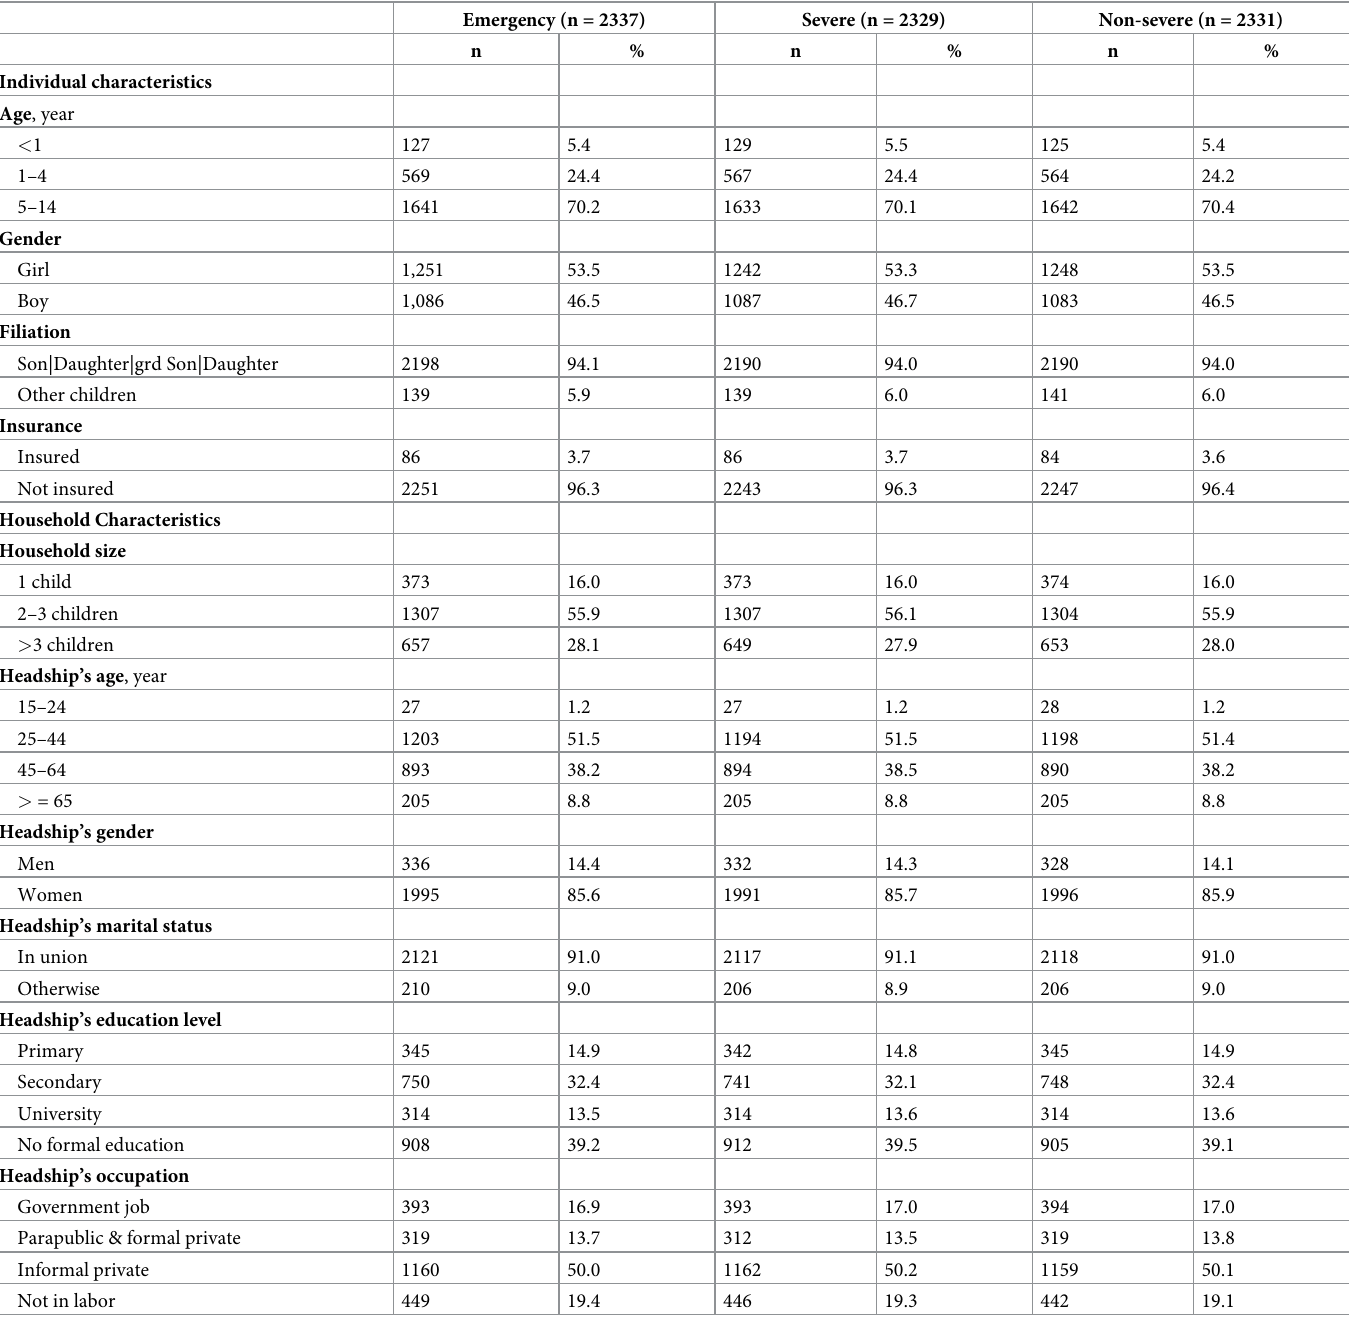
Table 2. Sample distribution by characteristics and types of health